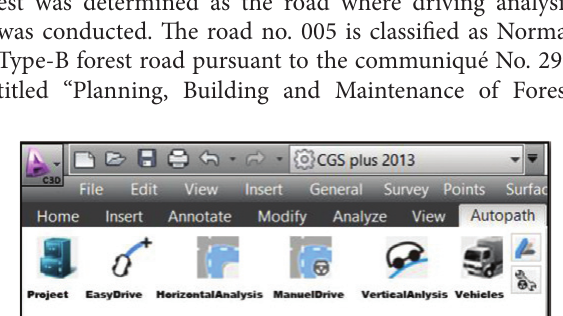
Table 2. Certain climate data from Bahcekoy Meteorology Station (1980–2009) according to State Meteorology Affairs General Directorate data of 2013 Parameters